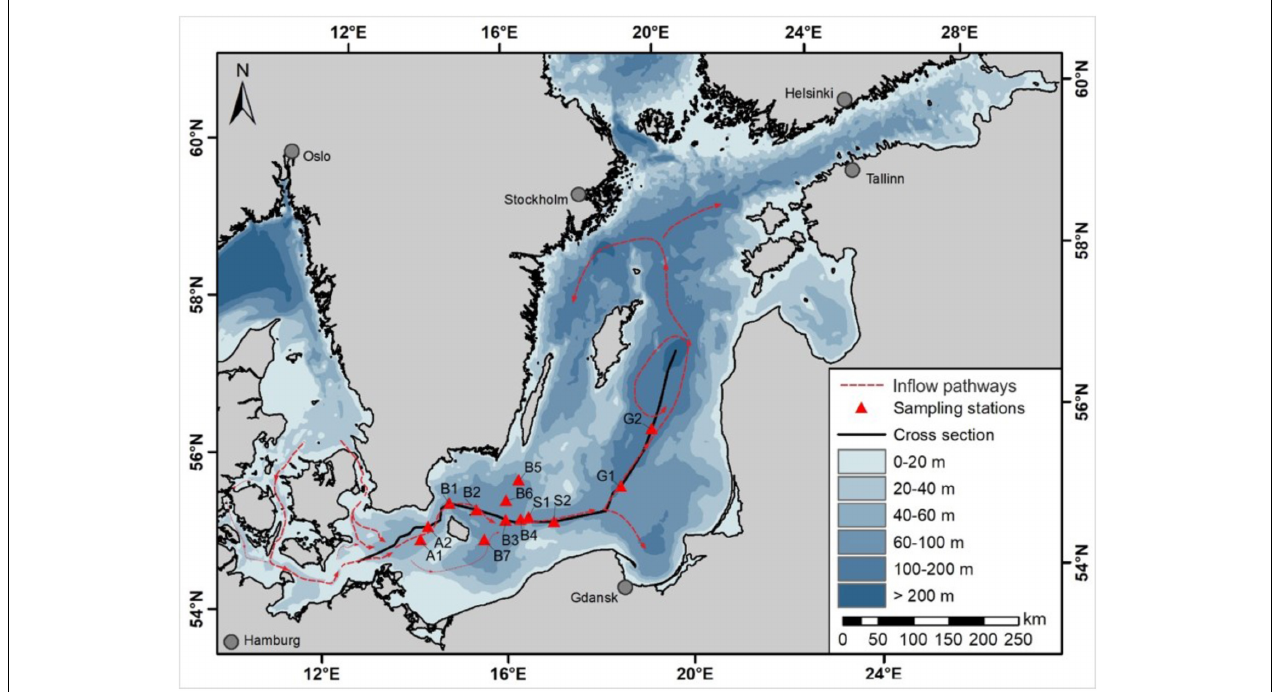
FIGURE 1 | Map of the Baltic Sea, showing the sampling stations (dots) and estimated state of the 2014 Major Baltic inflow (MBI) during the time of sampling (red